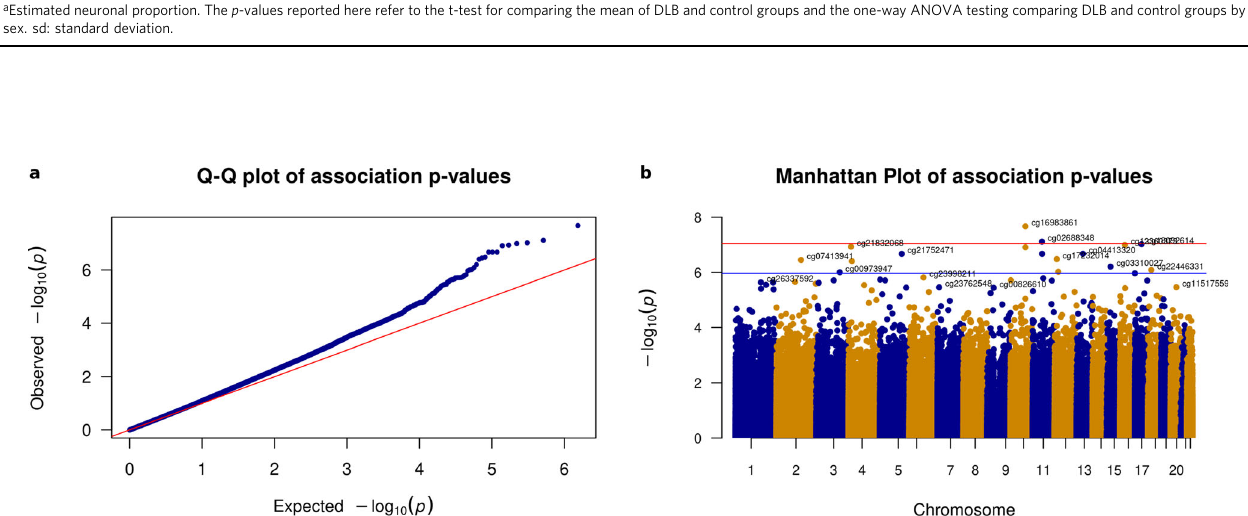
Fig. 1 The distribution of differentially methylated CpGs. a QQ-plot of the p -values from the EWAS model. The genomic control in fl ation rate of the EWAS model is 1.1, indicating a modest in fl ation. The x-axis shows the expected – log10 ( p -value), whereas the y-axis indicates the observed – log10 ( p- value). b Manhattan plot of the EWAS results between DLB and Control samples. The red line indicates the genome-wide signi fi cance threshold ( p- value = 9e-8) and blue line represents a q-value of 5 % adjusting for multiple comparisons. The top DMCs per chromosome are annotated.